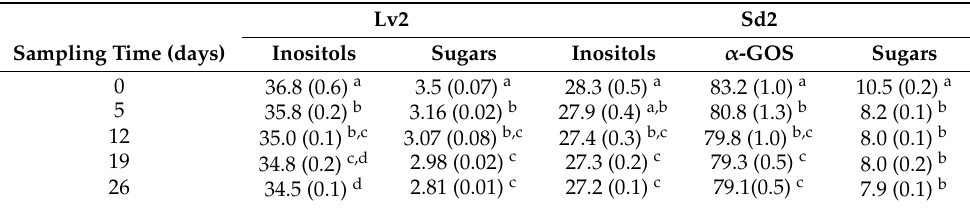
Table 4. Inositol, α -GOS, and sugar concentrations (mg g − 1 ) of MAE seeds (Sd2) and leaves (Lv2) lyophilized extracts stored at 50 ◦ C for different times. Standard deviation in brackets ( n = 3). Lv2 Sd2 Sampling Time (days) Inositols Sugars Inositols α